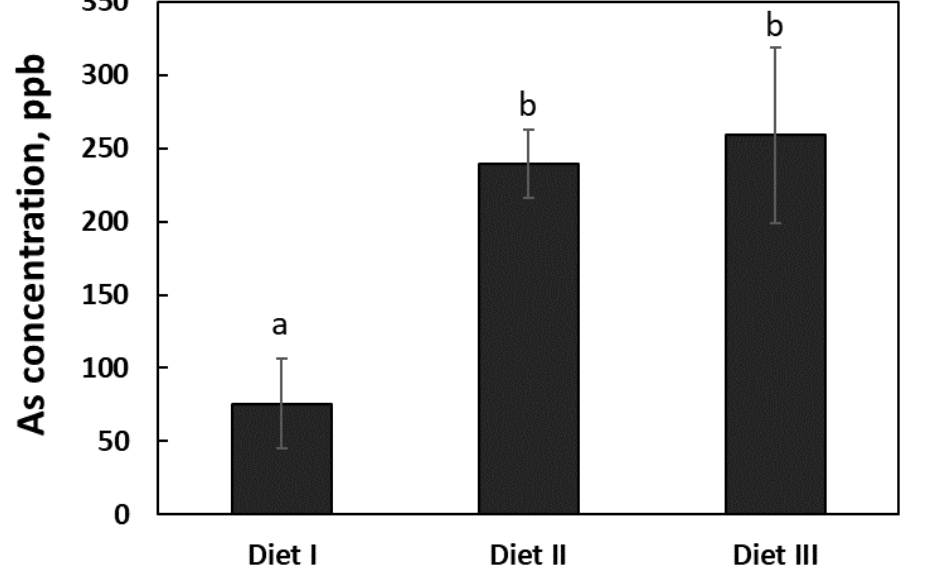
Figure 3. The concentrations of arsenic (As) in the urine of the pigs fed with three experimental diets. The rectangular bars represent the pattern of mean As concentrations in the urine after the feeding trial ( n = 6 for Diet I, and n = 7 for Diets II and III). The error bars represent the pooled standard error of the means. The means labeled with different letters (a, b) differ ( p < 0.05).